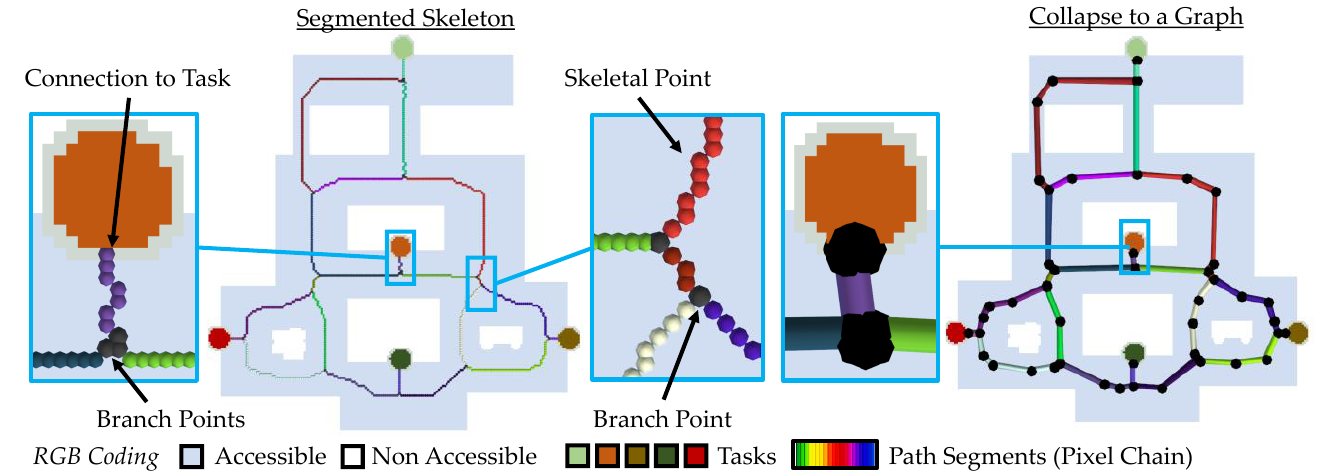
Figure 12. Simplification of paths in a graph: topological segmentation, simplification to polylines.